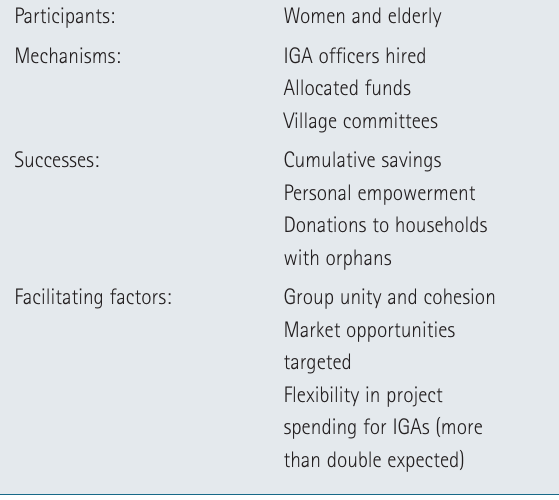
Fig. 2. Successful gardening and candlemaking IGAs at a rural site in Lesotho (Site 6).